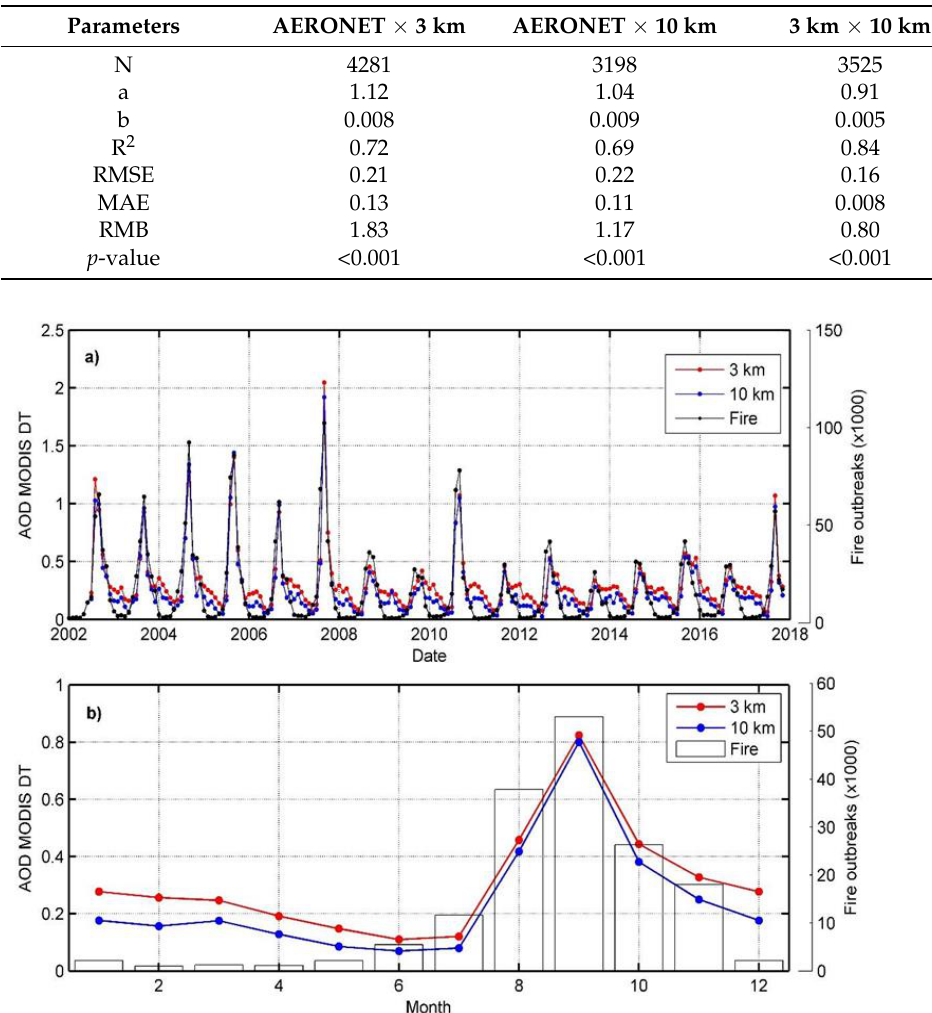
Figure 6. ( a ) Time series of integrated AOD measurements for MODIS DT 3 km and 10 km products (monthly average) and records of fire outbreaks over the Legal Amazon. ( b ) Characteristic year with average values for MODIS DT 3 km and 10 km products and records of fire